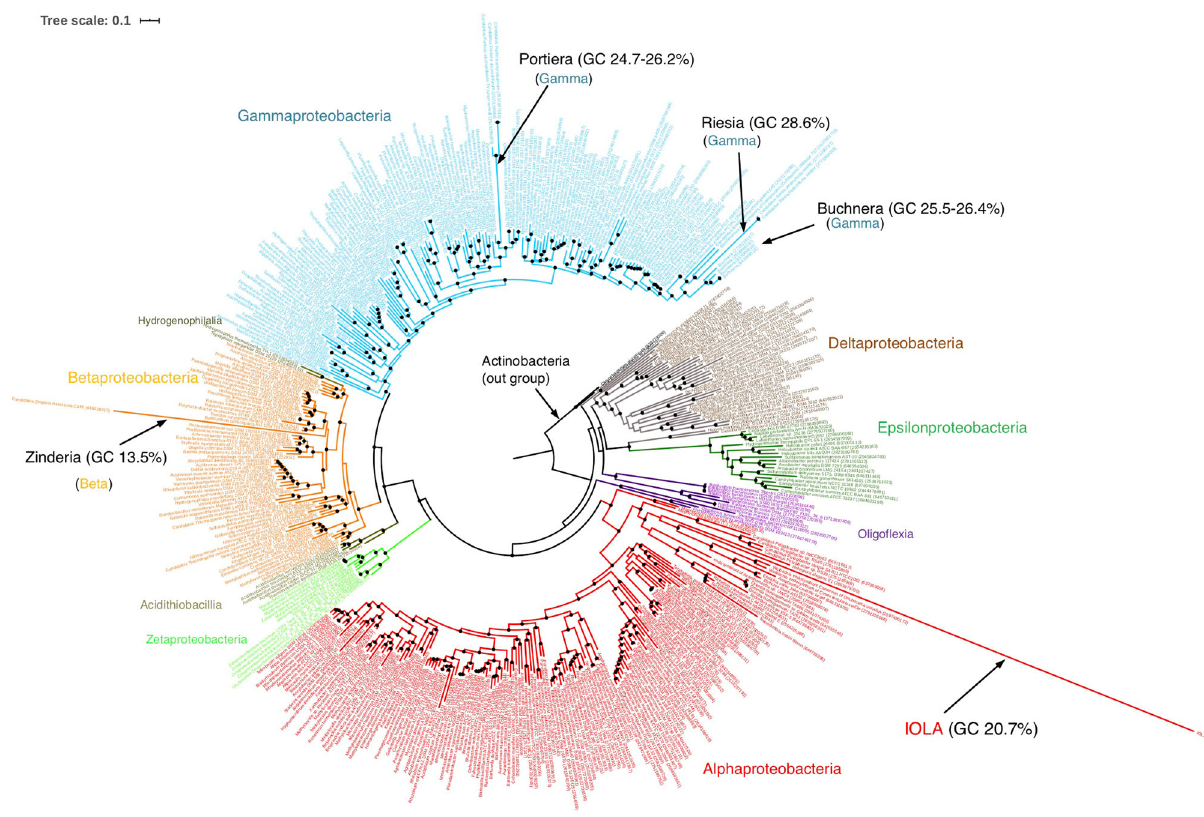
Fig. 3 Maximum likelihood phylogenetic tree based on the concatenated sequences of 16 ribosomal proteins of Proteobacteria. The tree includes 451 species belonging to phylum Proteobacteria, two species of Actinobacteria (used as outgroups) and IOLA (listed in Supplemental Data 2). A total of 454 sets of the 16 ribosomal proteins (RpL2, 3, 4, 5, 6, 14, 15, 16, 18, 22, and 24 and RpS3, 8, 10, 17, and 19) were used. Species belonging to the same class are presented in the same color. The tree was constructed using the 1895-position alignment by the maximum likelihood method with the LG + R10 model and 1000 ultrafast bootstrap replicates. The scale bar indicates substitutions per site. Black dots indicate divergence episodes with bootstrap values greater than 80%. Four species that have a small genome (<1.0 Mb) with a low GC content (<30%), such as IOLA, are